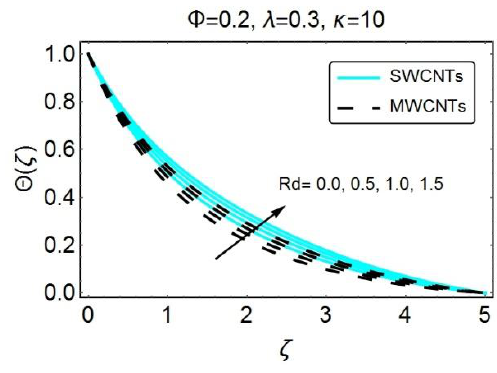
Figure 4. Θ(𝜁) for some values of 𝑅𝑑. Figure 4. Θ ( ζ ) for some values of Rd .